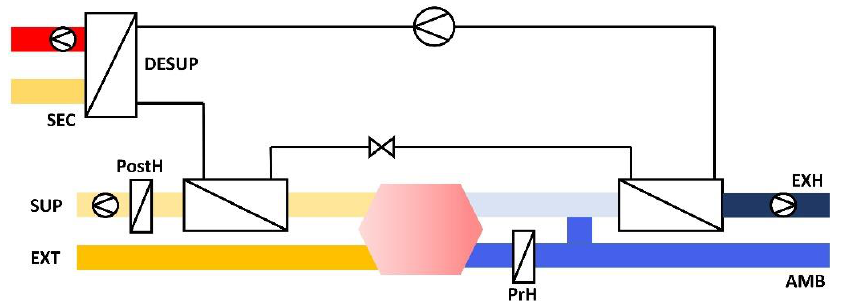
Figure 5. Scheme of supply-air heat pump with secondary air recirculation (SEC) with MVHR and with post-heater (PostH) and pre-heater (PrH) and desuperheater (DESUP).